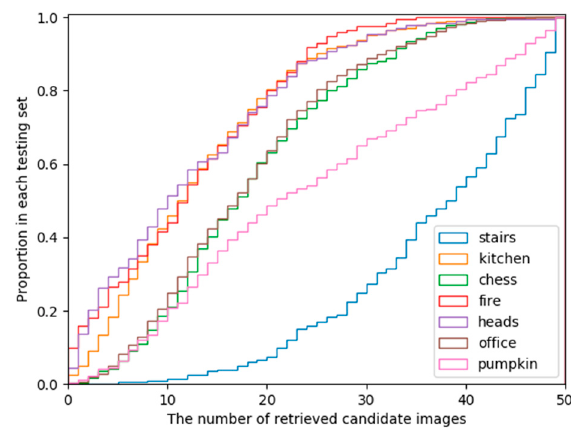
Figure 7. Cumulative proportion plot for each separate testing set (top 50 images are retrieved).